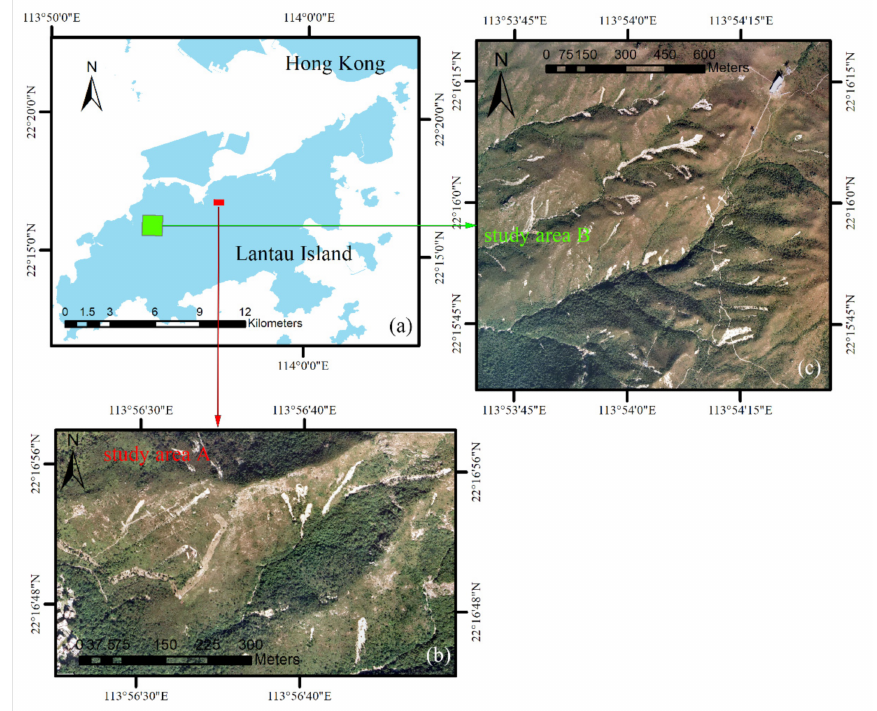
Figure 8. Geographic location and aerial photo of the study area. ( a ) Geographic location of study areas A (marked in red rectangle) and B (marked in green rectangle). ( b ) Aerial photo of study area A. ( c ) Aerial photo of study area B.